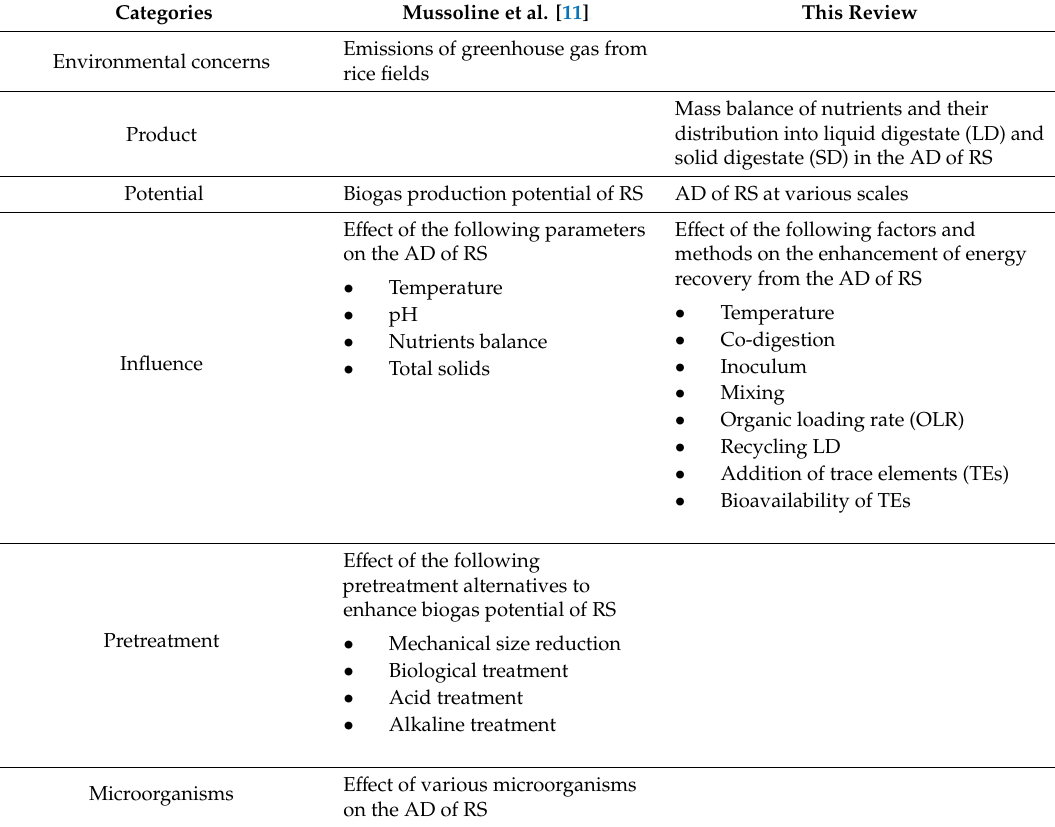
Table 1. Aspects of anaerobic digestion (AD) of rice straw (RS) discussed in both